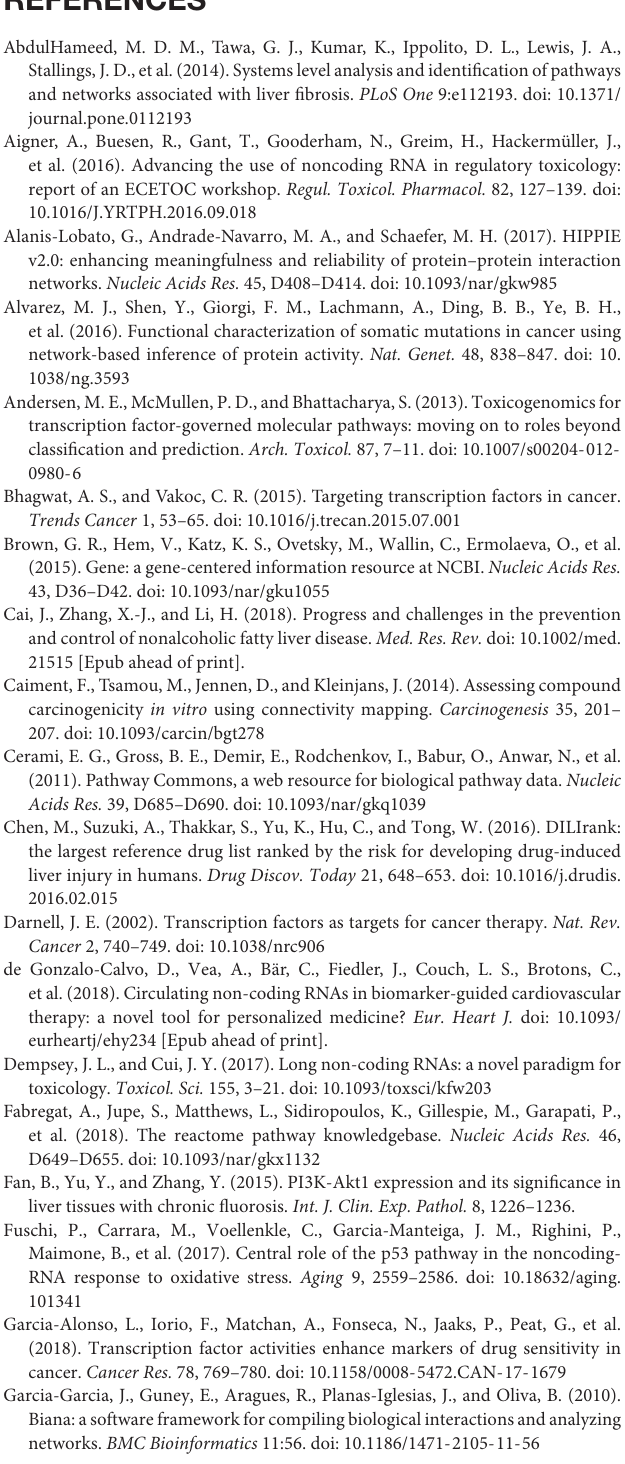
DATA SHEET S1 | Supplementary